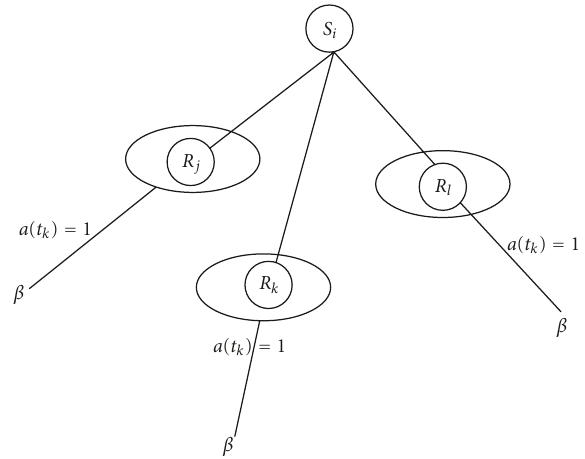
Figure 6: Example 1. Extensive form representation of a cooperative network with perfect information; R j , R l , and R k denote cooperative relay nodes and S i denotes source node i . Note the absence of Nature in this